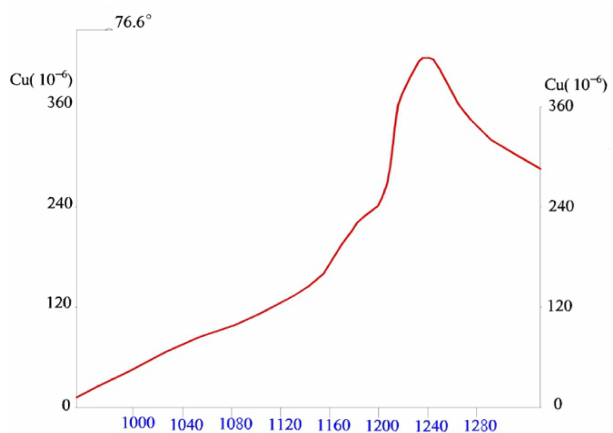
Figure 19. Anomaly of geochemical exploration of mining area along the survey line.